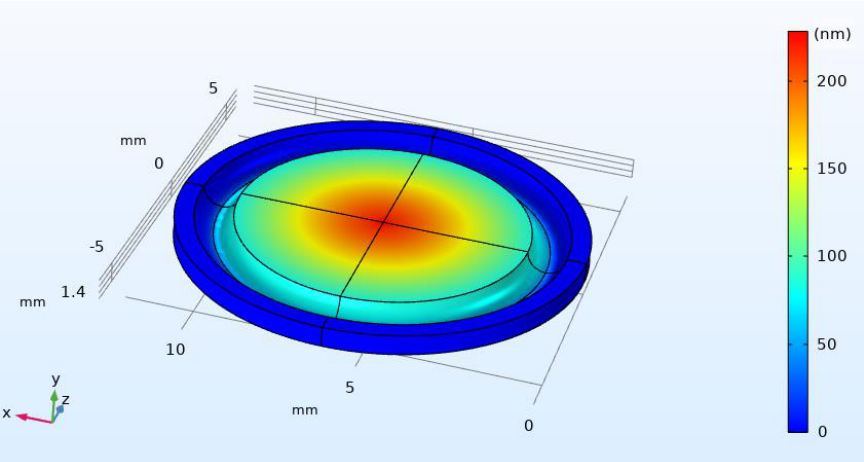
Figure 10. Upper substrate displacement at the original design scale (scaling factor 1) in the mechanical model.